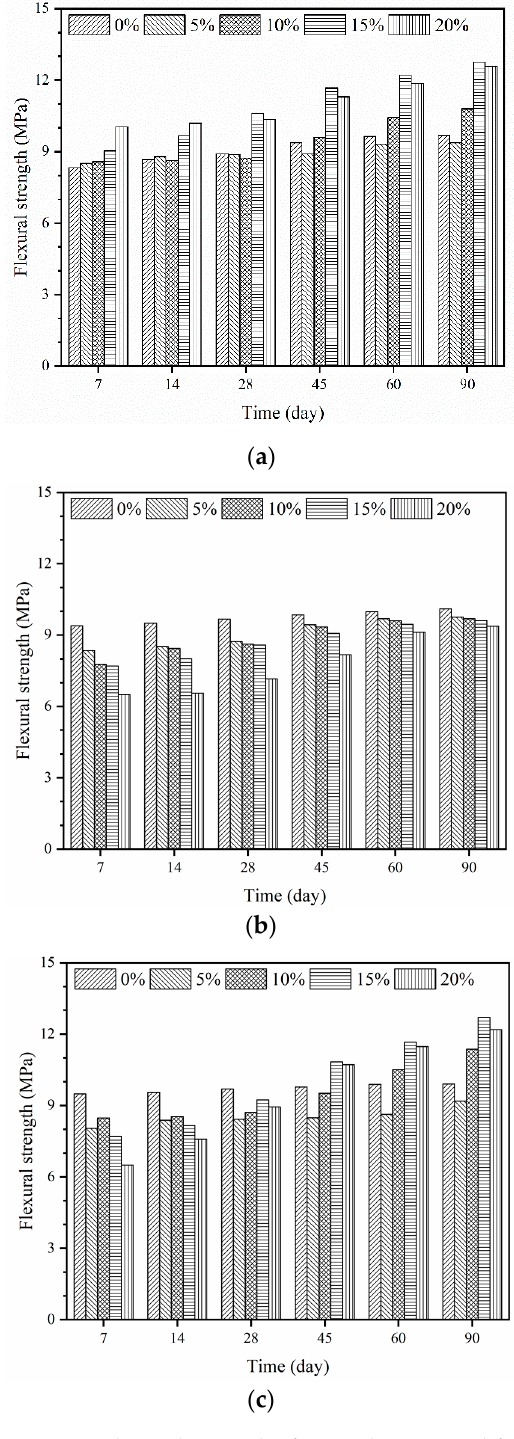
Figure 7. Flexural strength of epoxy latexes modified mortar: ( a ) dry curing, ( b ) wet curing, and ( c ) wet–dry curing.